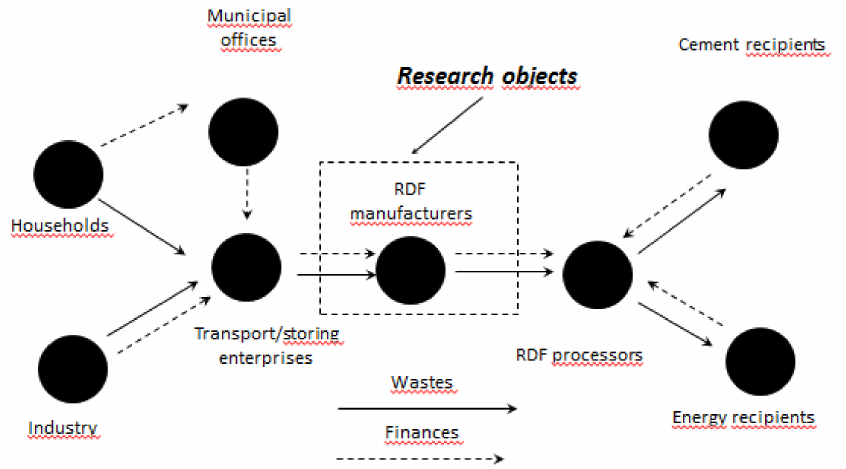
Figure 1. The case study research